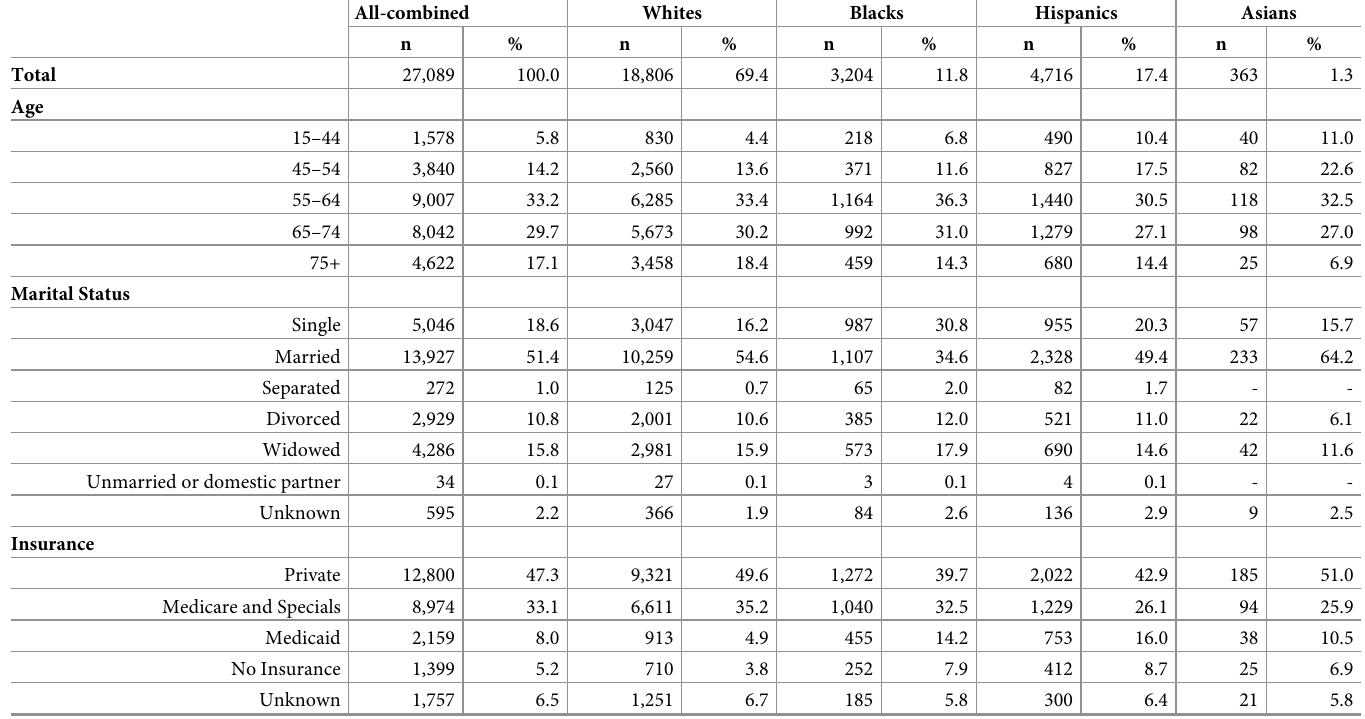
Table 1. Population characteristics and clinical features of endometrial cancers by race/ethnicity. Florida